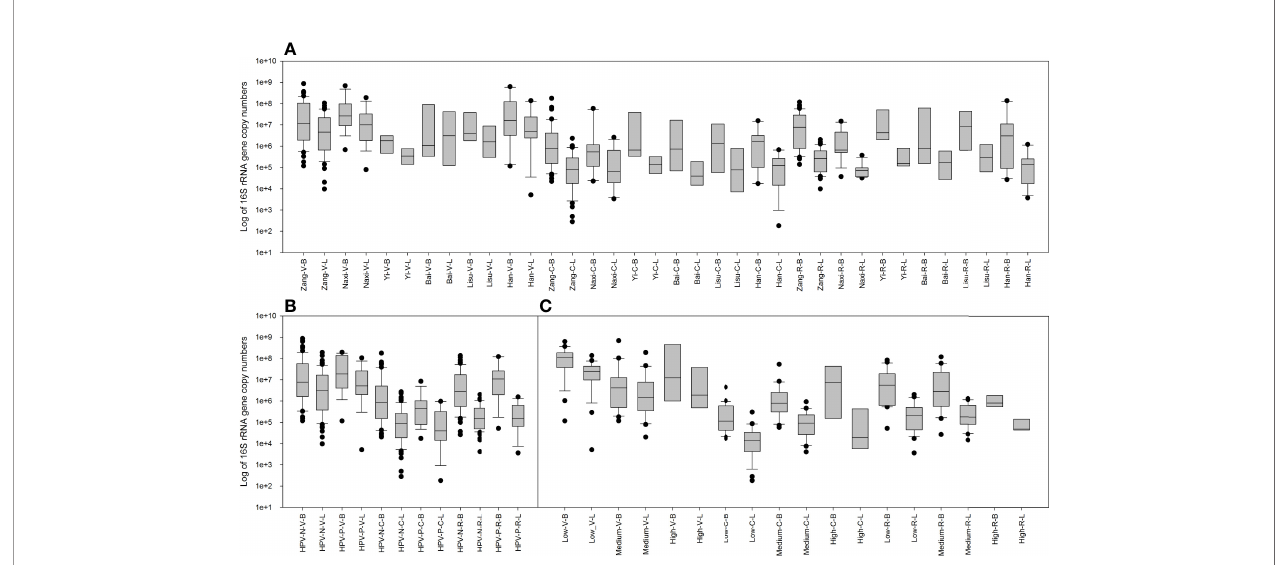
FIGURE 6 | Copy numbers of the total bacterial and Lactobacillus 16S rRNA genes measured by quantitative real-time PCR. (A) Comparison between 16S rRNA gene copy numbers in the total bacteria and Lactobacillus among six ethnic groups in vaginal, cervical, and rectal swab samples. (B) Comparison between 16S rRNA gene copy numbers in the total bacteria and Lactobacillus among HPV-negative and HPV-positive samples in vaginal, cervical, and rectal swabs. (C) Comparison between 16S rRNA gene copy numbers in the total bacteria and Lactobacillus among low-, medium- and high-level cytokine clusters in vaginal, cervical, and rectal